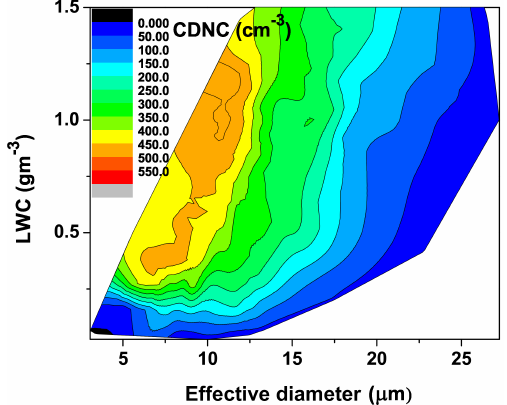
Figure 2. The contour plot shows the relationship between cloud microphysical parameters, cloud droplet number concentration (CDNC), droplet effective diameter (ED), and LWC. ED decreases with increase in CDNC for all